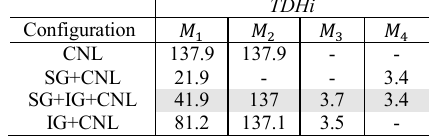
Table X. Values of THDi (%) in 𝑀 1 ,𝑀 2 ,𝑀 3 𝑒 𝑀 4 with 𝑁 𝐿 .